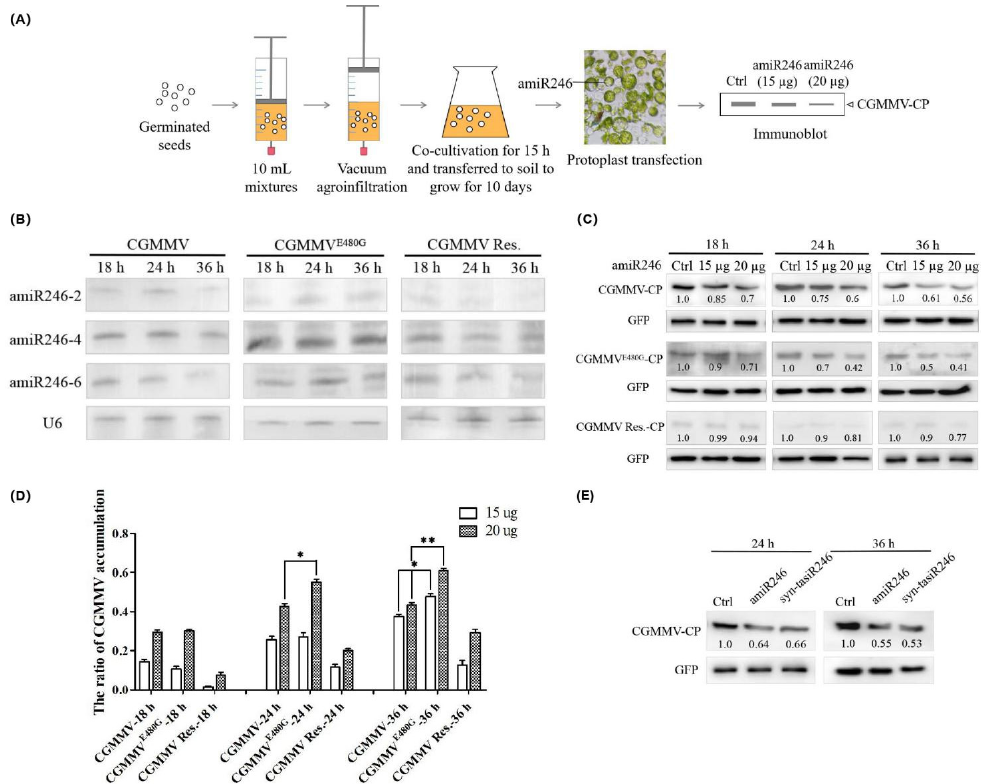
Figure 6. Biological activity of the polycistronic amiR246 construct in CGMMV-infected cucumber protoplasts. ( A ) Schematic diagram of infecting seeds with CGMMV, Agrobacterium introduction of amiR246, and protoplast preparation from germi- nating cucumber seeds. After co-cultivation, the CP protein of CGMMV was detected via immunoassays. ( B ) Northern blot analysis of the expression level of amiRNA at three time points (18, 24, and 36 h) of incubation under different virus strain infections. The U6 blot represents a loading control. ( C ) CGMMV CP levels detected via Western blot in cucumber protoplasts infected with viruses at different incubation time points. Each treatment was repeated in three independent replicates, and the GFP was used as an untargeted internal control. ( D ) Calculation of the inhibition rate of virus accumu- lation in response to different amounts of amiRNAs (the difference in virus accumulation between the amiRNA group and the control group compared with the control group) shows the inhibitory effect of amiRNAs on virus accumulation of different virulence. Values are the mean ± standard deviation obtained from at least three independent experiments. **, p -value ≤ 0.01; *, p -value ≤ 0.05. ( E ) Compare the effect of amiR246 and syn-tasiR246 on virus accumulation at two time points (24 and 36 h). CGMMV E480G , the mutation of the 480th amino acid of the CGMMV infectious clone vector from glutamic acid (E) to glycine (G). CGMMV Res., the mutation of the target sequences of amiRNAs in the CGMMV infectious clone vector, with less than five